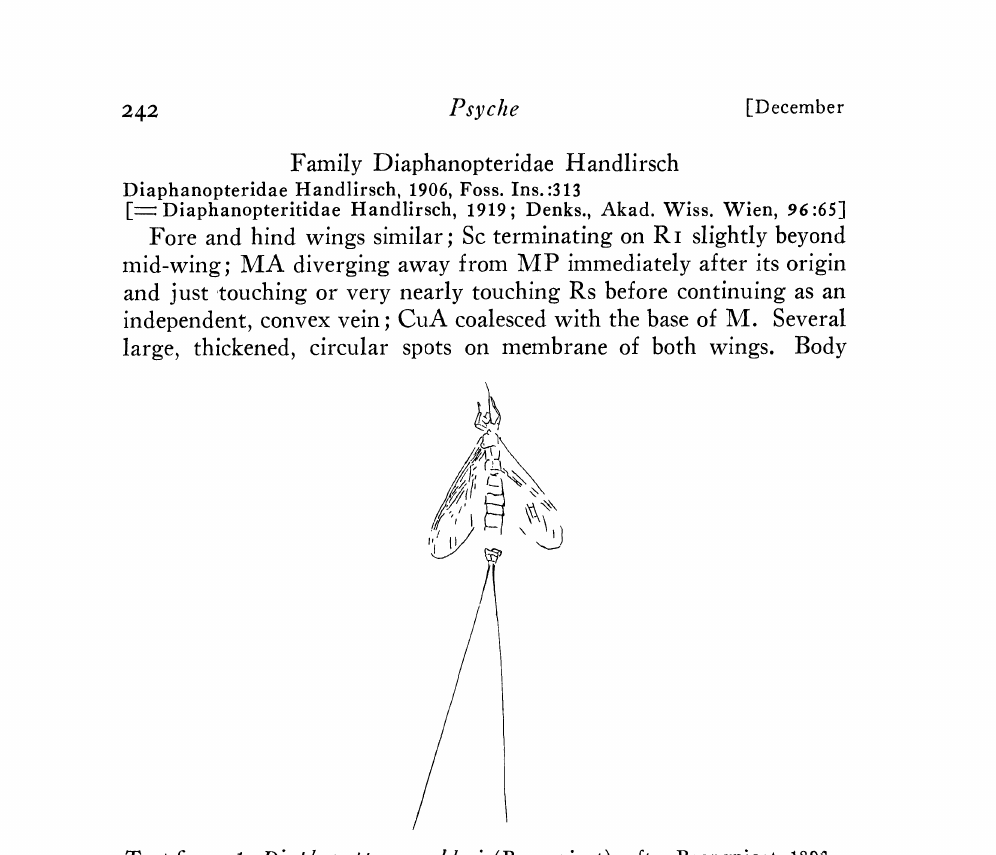
Text figure 1. Diaphanoptera scudderi (Brongniart), after Brongniart,